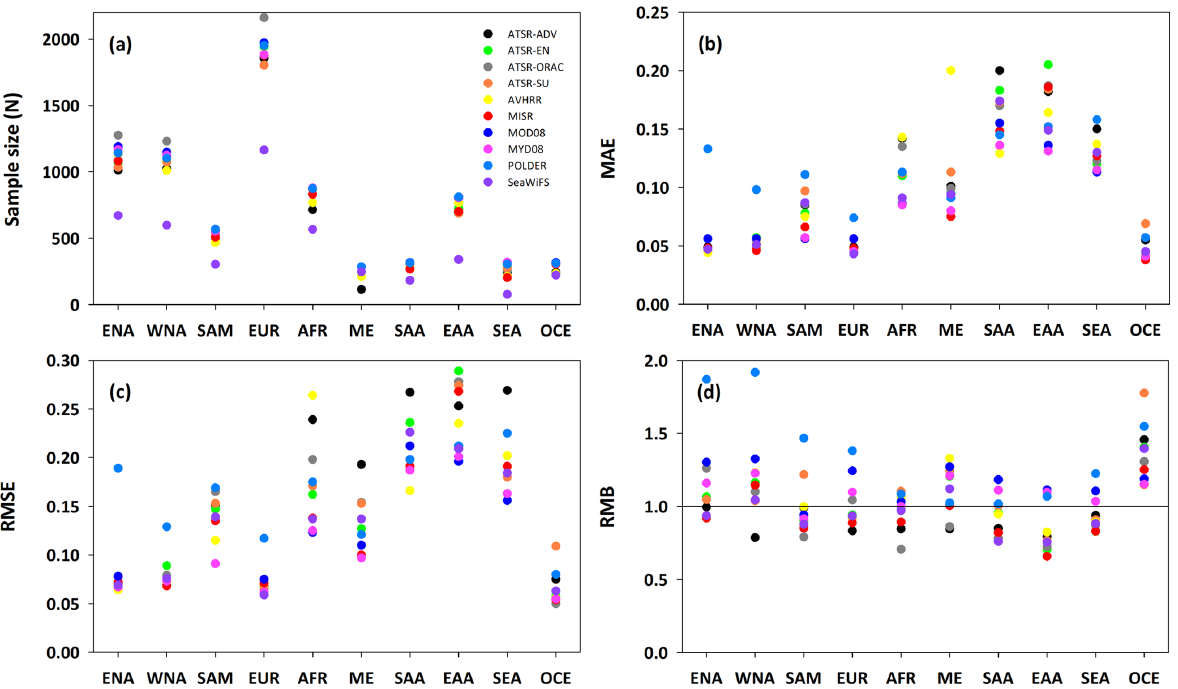
Figure 3. Continent-scale performance for satellite-derived monthly AOD S against AERONET monthly AOD A measurements from 2006 to 2010 in terms of (a) sample size ( N ), (b) MAE, (c) RMSE, and (d)